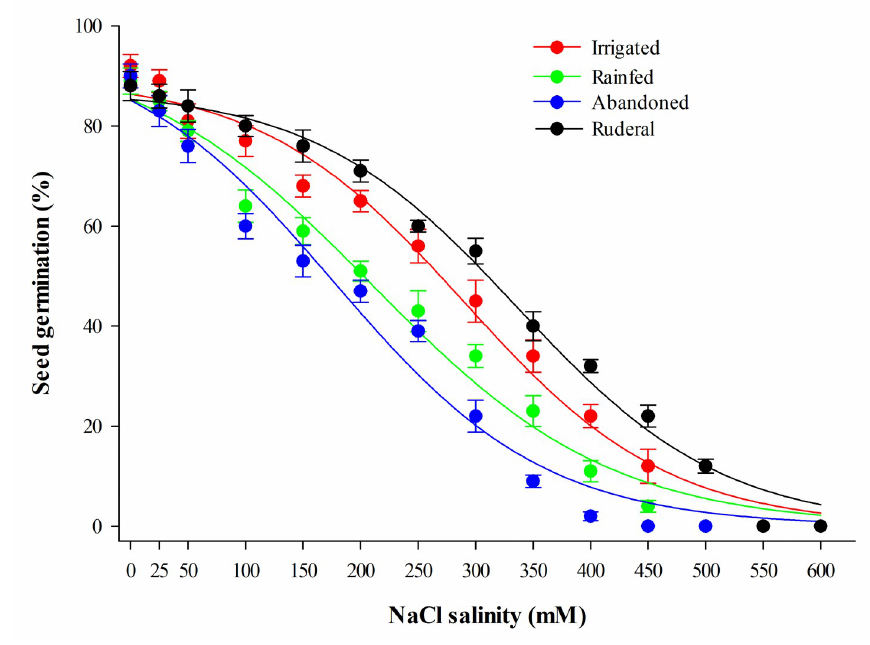
Fig 4. The influence of different salinity levels on seed germination of Conyza stricta Willd. The vertical bars present standard errors of means (n = 10).